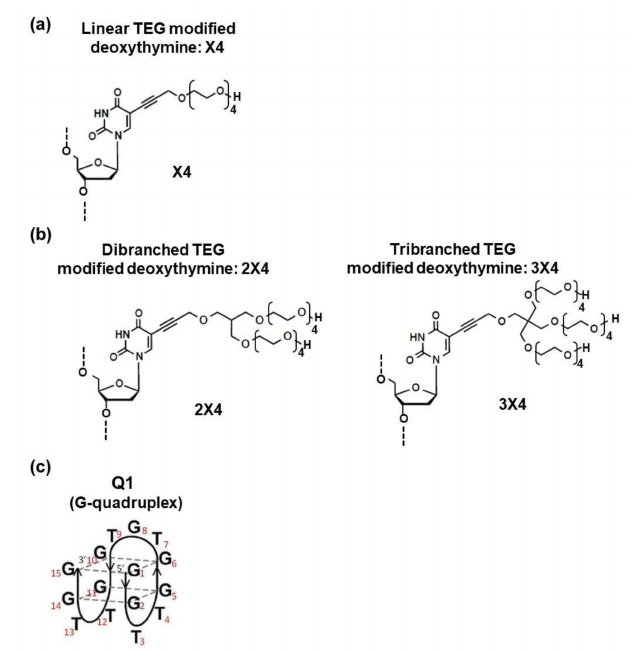
Figure1. Chemicalstructuresof( a )linear(X4), ( b )dibranched(2X4), andtribranched(3X4)tetraethylene glycol (TEG)-modified deoxythymines. The linear TEG-modified deoxythymine (X4) was previously described [16,17]. ( c ) Schematic structure of the antiparallel G-quadruplex (Q1) used in this